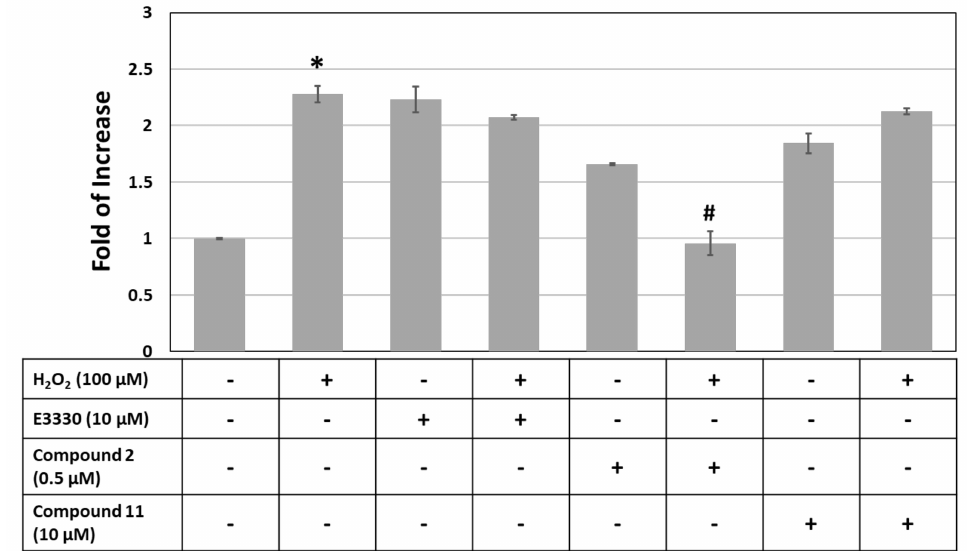
Figure 4. Inhibition of AP-1 transcriptional activation in human melanoma A375 cells by compound 2 . A375 cells were transfected with an AP-1 luciferase reporter plasmid. 24 h after transfection, cells were incubated with H 2 O 2 (100 µ M) in the presence or absence of compound 2 (0.5 µ M), compound 11 (10 µ M), or E3330 (10 µ M) for 48 h. After treatment, the cells were harvested to determine the luciferase activity, expressed as fold of control without treatment. The results normalized by cell numbers represent means ± SD of triplicates. * p < 0.05 compared to control; # p < 0.05 compared to H 2 O 2